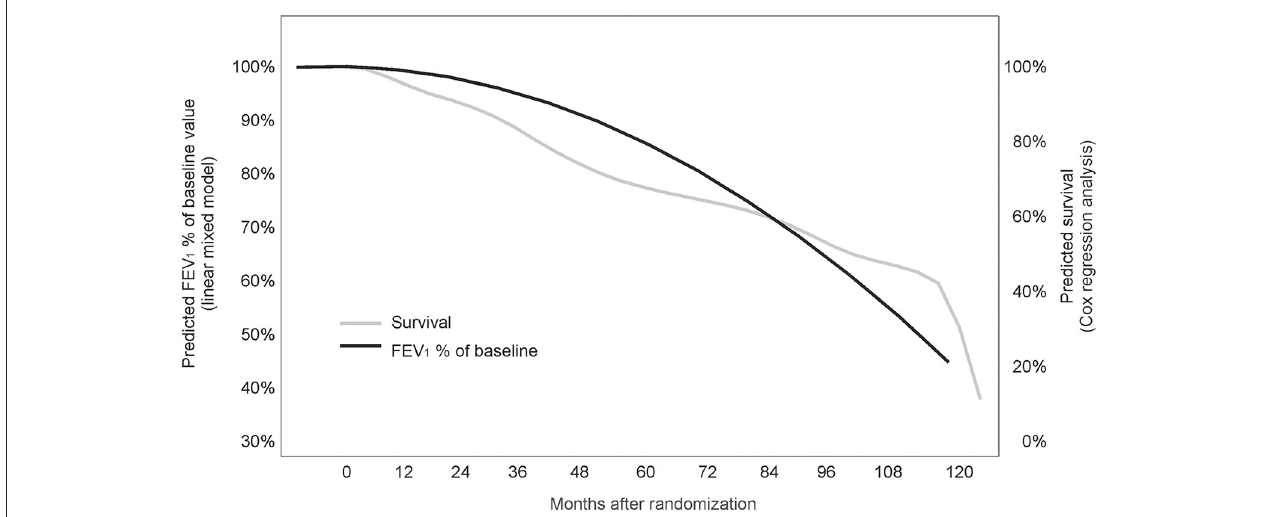
FIGURE 2 | Association between FEV1 baseline % of the baseline value and survival (joint model analysis). The predicted association between FEV1% of baseline value and mortality risk is illustrated graphically.